Question: Is the quantity shown trending increasing or decreasing?
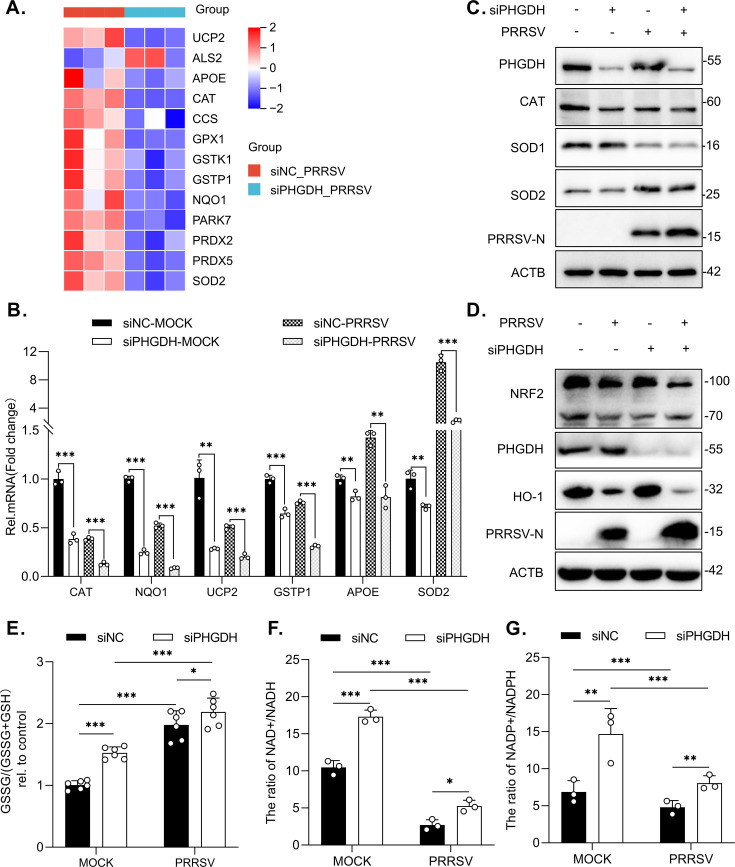
Answer: decreasing